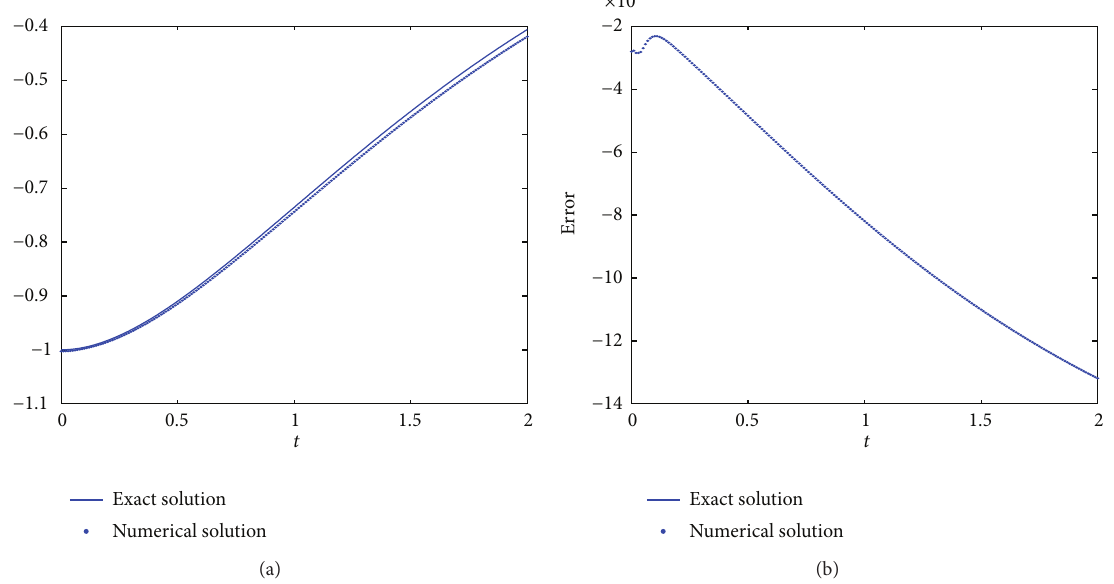
̂𝑓(𝑡) ̂𝑓(𝑡) (a), the error 𝑓(𝑡) − (b) with Δ𝑥 = 0.1 , Δ𝑡 = 0.01 .